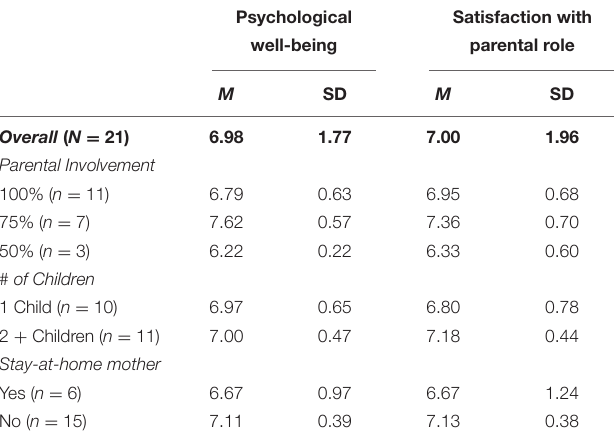
TABLE 3 | Descriptive data on mothers’ psychological well-being and